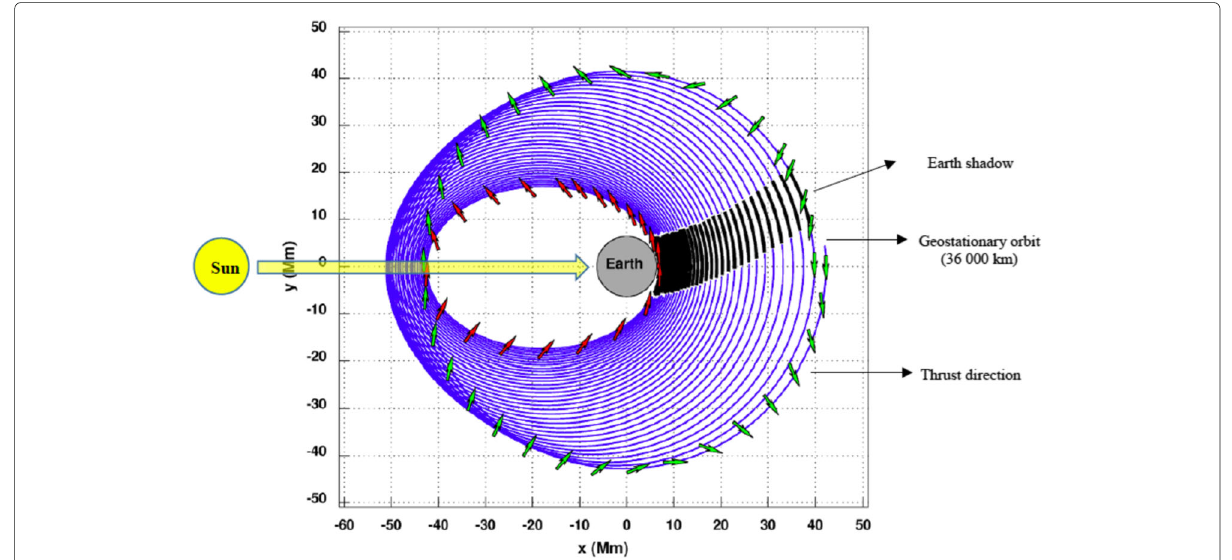
Fig. 3 Low thrust orbit raising toward the geostationary orbit